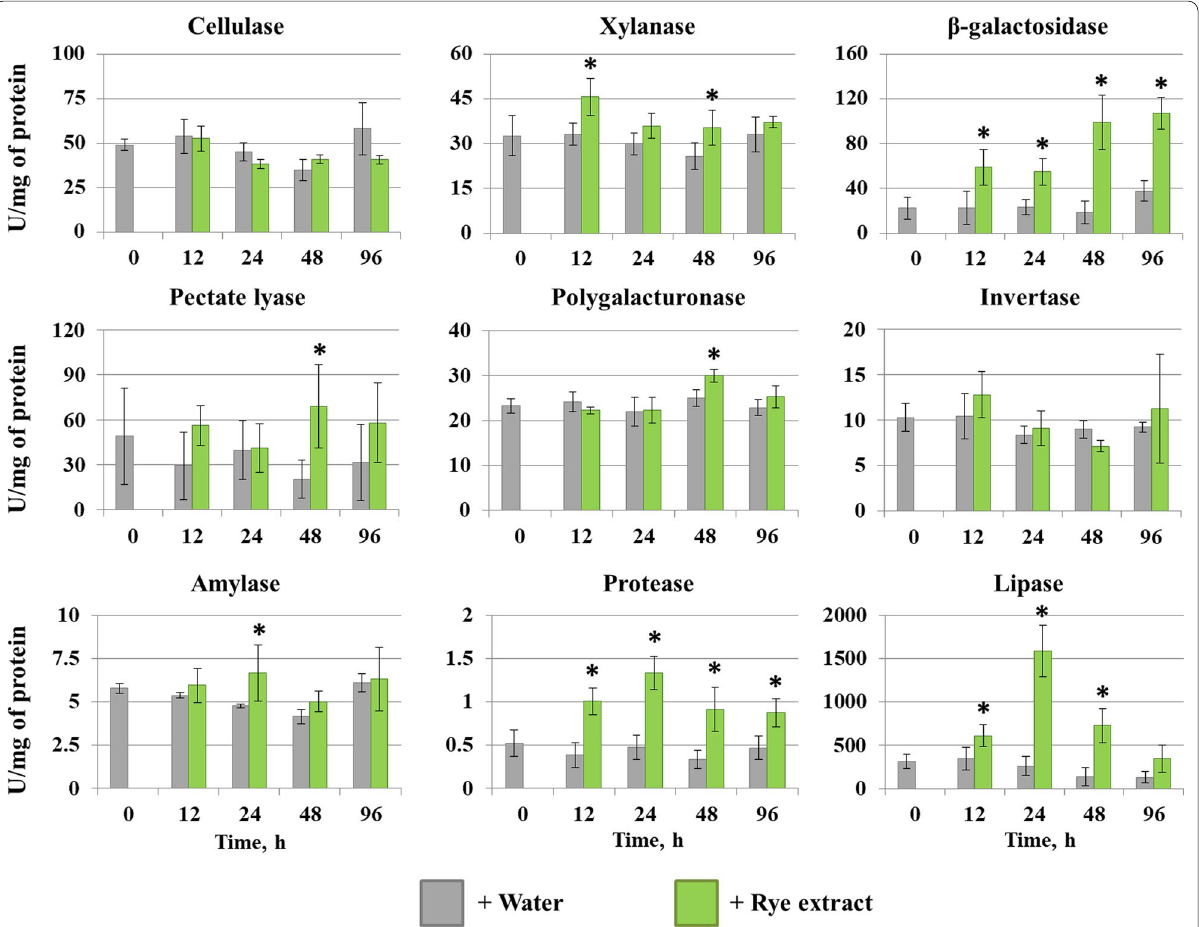
Fig. 6 The effect of the extract of rye leaves on the extracellular cellulase, xylanase, β-galactosidase, pectate lyase, polygalacturonase, invertase, amylase, protease, and lipase activities of the Microdochium nivale F_00608. Fungal cultures (grown for 10 days in minimal medium) were supplemented with rye extract (green columns) or water (gray columns) and then the enzymatic activities were measured. The presented values are averages SD of five biological replicates. The stars show significant differences (Mann–Whitney U test, p-value < 0.05) between samples with ± and without rye